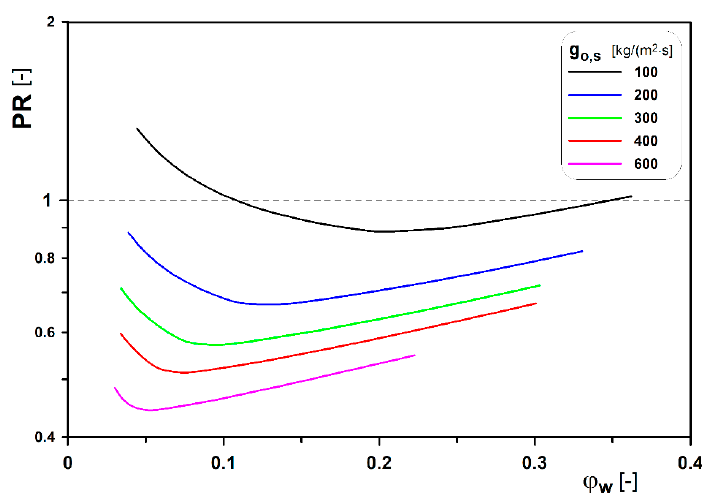
Figure 9. Variations in PR index for oil with the viscosity of η r =100.